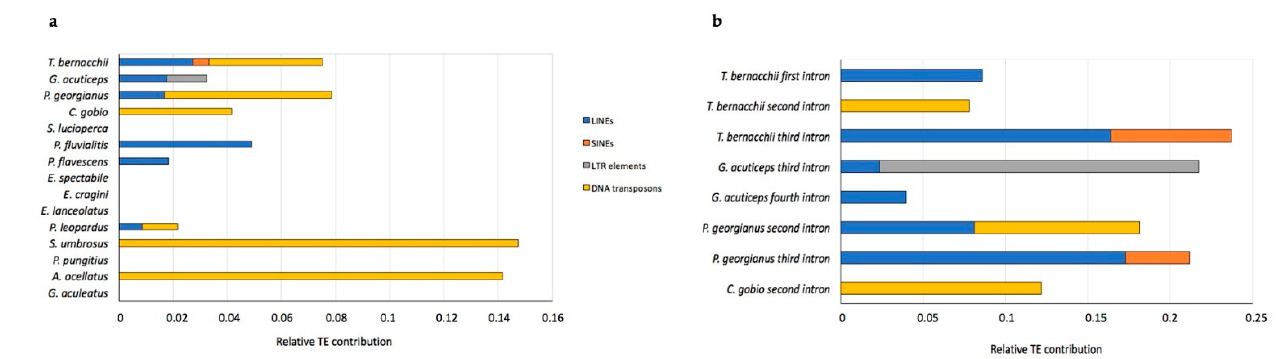
Figure 2. Presence of transposable elements (TEs) in the pIgR gene from notothenioids and other perciform species. ( a ) Distribution of TEs in overall pIgR intronic sequences of representatives of each perciform suborder; ( b ) distribution of TEs found in each of the first four pIgR introns of Antarctic and non-Antarctic species.